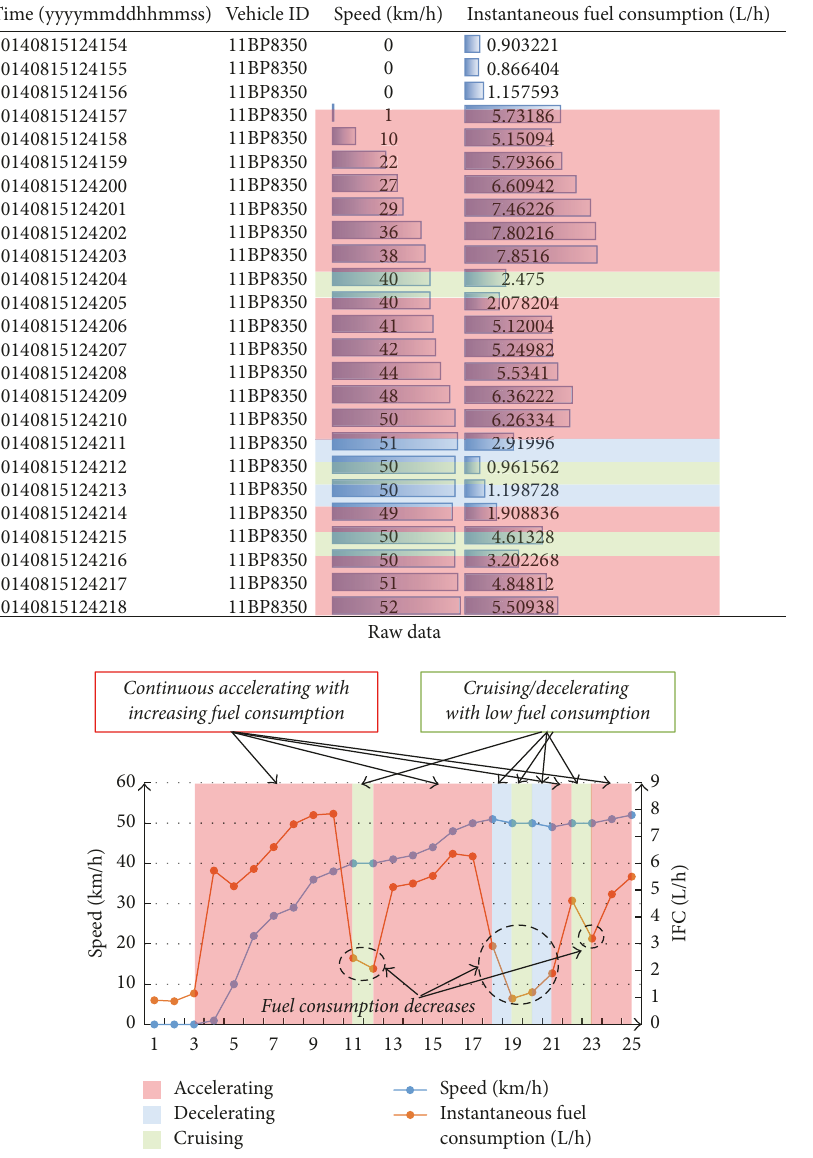
Figure 2: Positive correlation between vehicle instantaneous fuel consumption and the duration time of